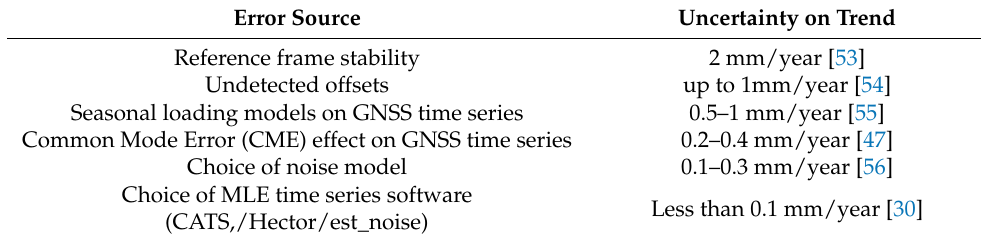
Table 2. Various sources of errors which influence the uncertainty of the estimated